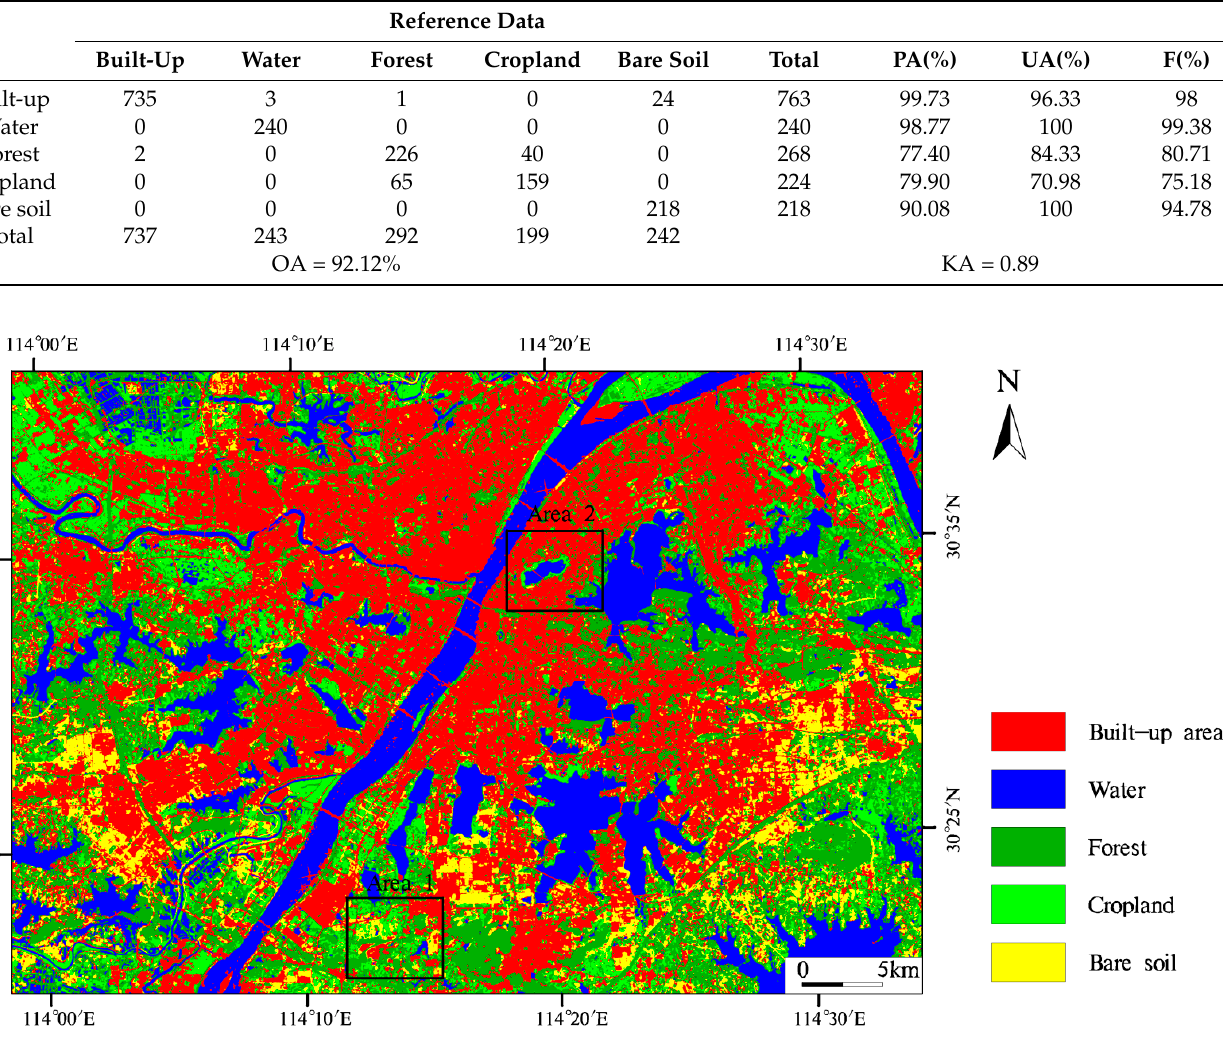
Table 4. Confusion matrix of the classification results using the combination of Sentinel-2B MSI and Sentinel-1A SAR data.